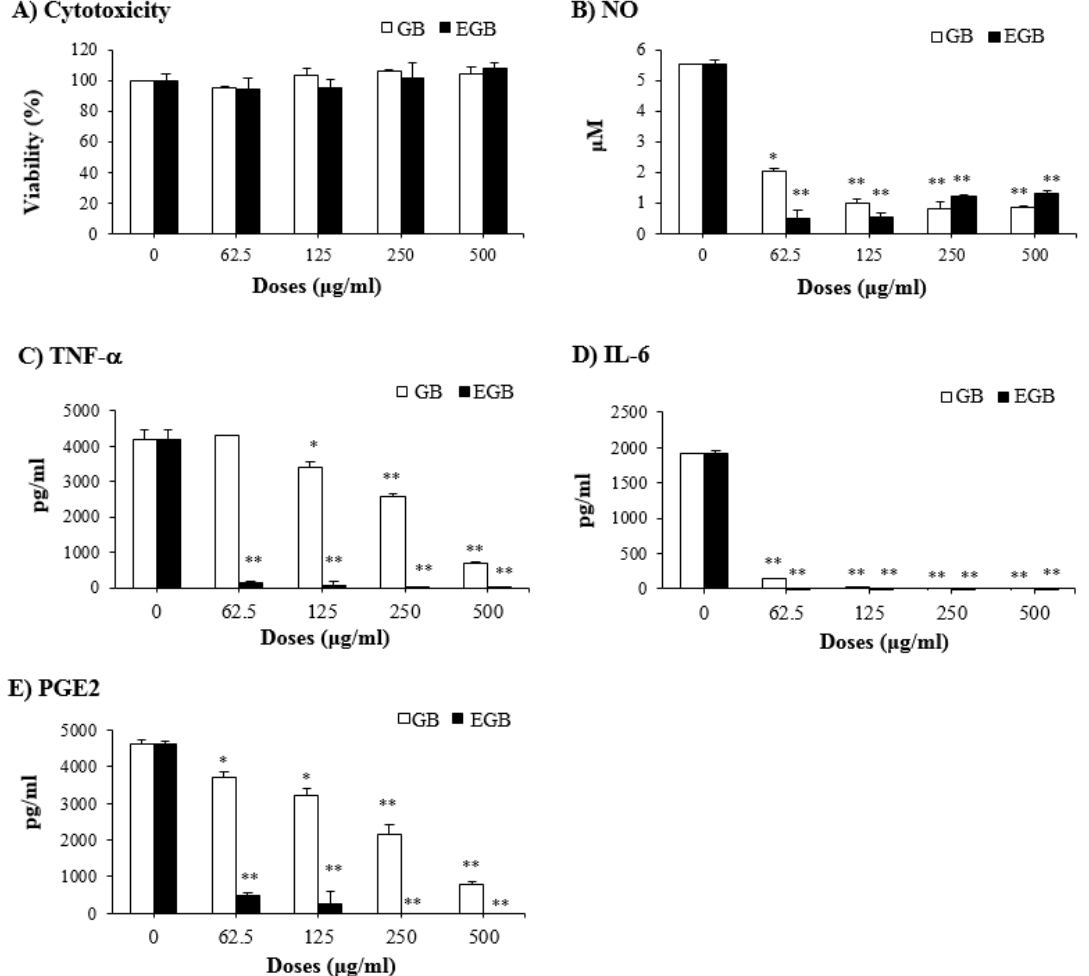
Figure 8. Anti-inflammatory effect of EGB in LPS-stimulated RAW 264.7 macrophages. The RAW 264.7 cells were pretreated with the indicated doses of EGB or GB for 15 h, and then stimulated with LPS (1 μg/mL) for 24 h. Cell viability ( A ) was determined by the MTT assay. The concentrations of NO ( B ), TNF- α ( C ), IL-6 ( D ), and PGE 2 ( E ) in the culture supernatants were measured by commercial sandwich ELISA kits. * p < 0.01, ** p < 0.001, compared with the EtOH-fed group.